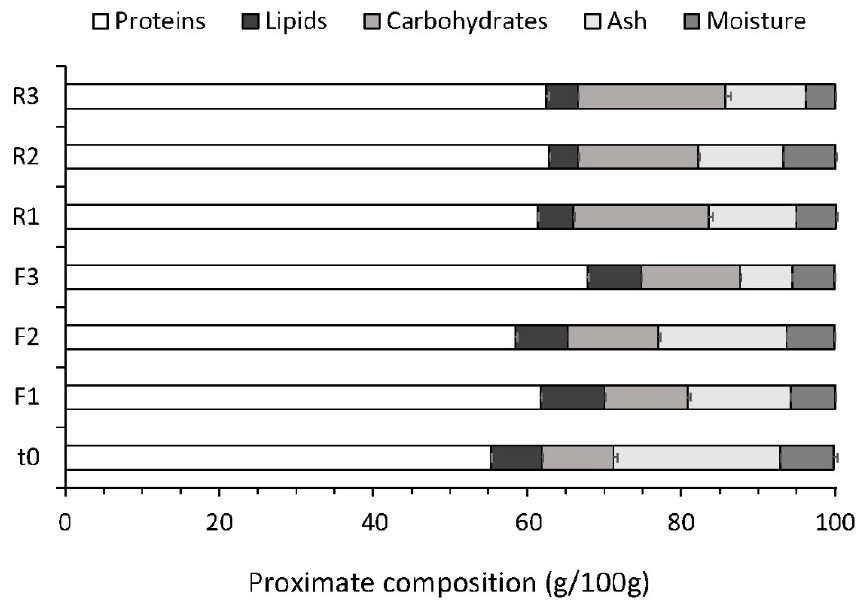
Figure A2. Biomass proximate composition (as % of proteins, carbohydrates, lipids, ash and moisture) for samples of A. platensis BEA 1257B collected at the time of inoculation (t0), during the first phase (F phase, 12 Sep. to 11 Oct., samples F1, F2 and F3) and during the second phase of the experiment (R phase, 11 Oct. to 11 Nov., samples R1, R2 and R3) from the 8000 L raceway pond inside greenhouse during the long-term semi-continuous cultivation, individually. Data are presented as the mean of three technical replicates, with error bars representing the corresponding standard deviation ( ± SD). Legend: White graph bars—Proteins; Black graph bars—Lipids; Gray graph bars—Carbohydrates; Light gray graph bars—Ash; Dark gray graph bars—Moisture.